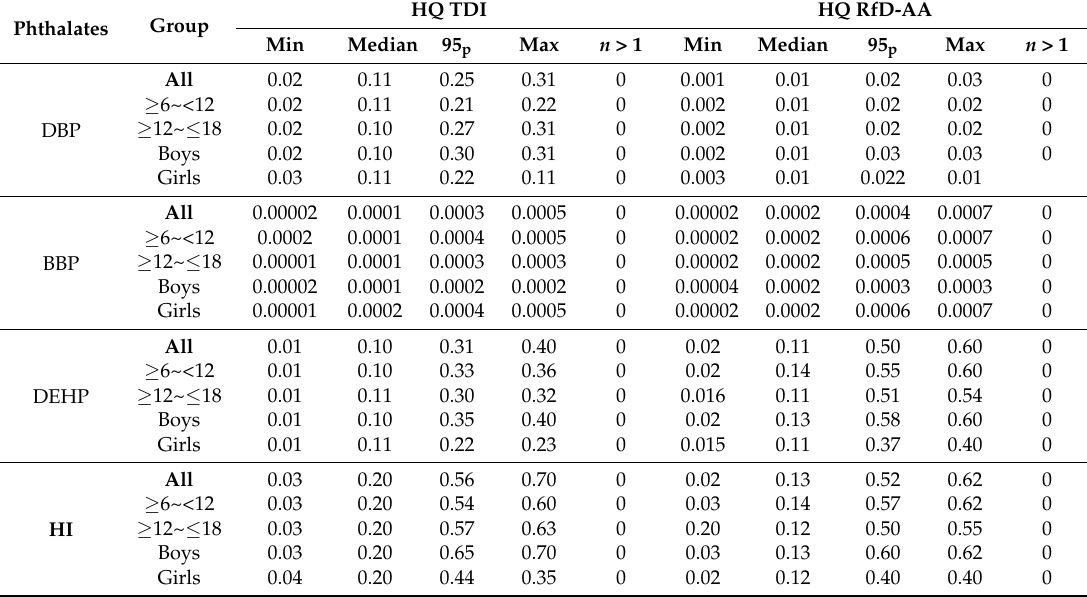
Table 6. Hazard quotients (HQ) and Hazard Index (HI) based on TDI (EFSA) and RfD-AA for Iranian children and